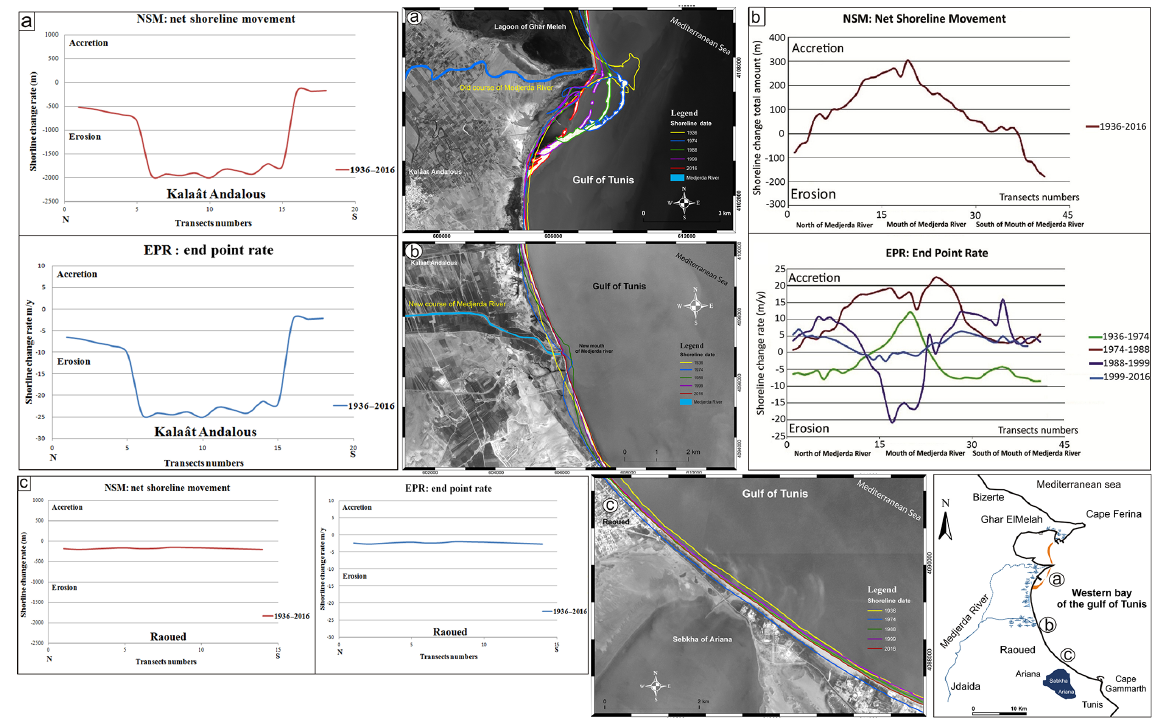
Figure 2. The diachronic shoreline evolution analysis at the deltaic and sandy beaches of the Gulf of Tunis, Tunisia. The Net Shoreline Movement (NSM) and The End-Point Rate (EPR) during the 1936–2016 period. The End-Point shoreline change Rates for the Gulf of Tunis beaches clearly show the erosion-dominated shoreline trend. Negative values indicate erosion. © Google Maps Software: Esri ArcGIS 10.2.